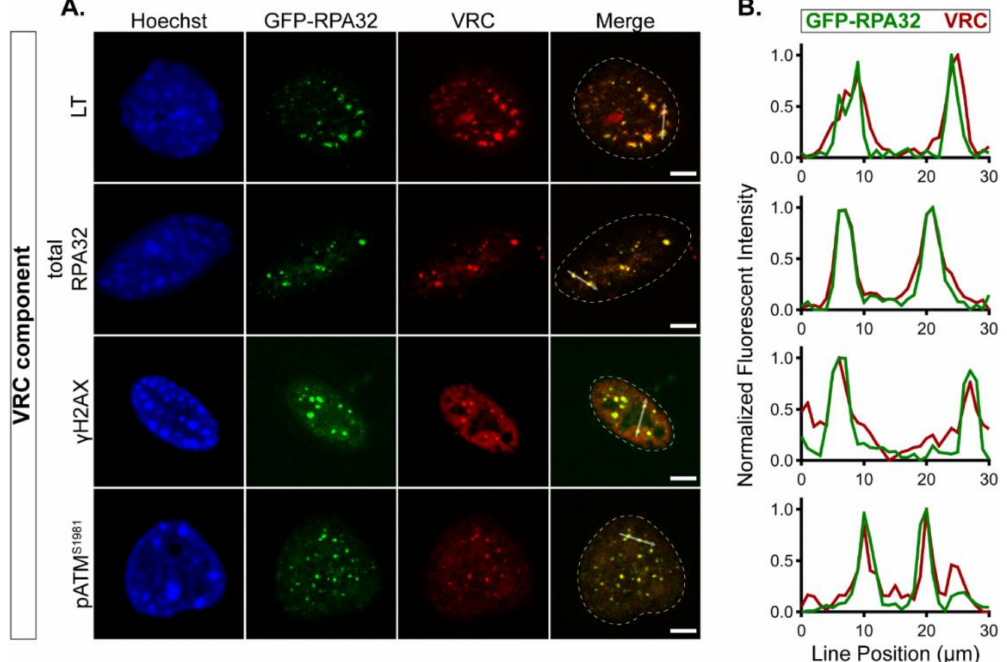
Figure 2. GFP-RPA32 relocalizes to viral replication centers (VRCs) in murine polyomavirus (MuPyV)-infected cells. GFP-RPA32-expressing cells were infected for 28 h and processed for immunofluorescence microscopy. ( A ) One z-position of a representative cell is shown for each immunolabeled VRC component designated on the left: large tumor antigen protein (LT), total RPA32 (endogenous and GFP-RPA32), γ H2AX, and pATM S1981 . Channels: Hoechst = blue, GFP-RPA32 = green, VRC components = red. The nuclear border is denoted by a dotted white line in each merge image. Scale bar = 5 µ m. ( B ) Line scan analysis of GFP-RPA32 (green) and VRC component (red) signals along the white arrow in each merge image in ( A ). Fluorescence intensities were analyzed and normalized as in Figure